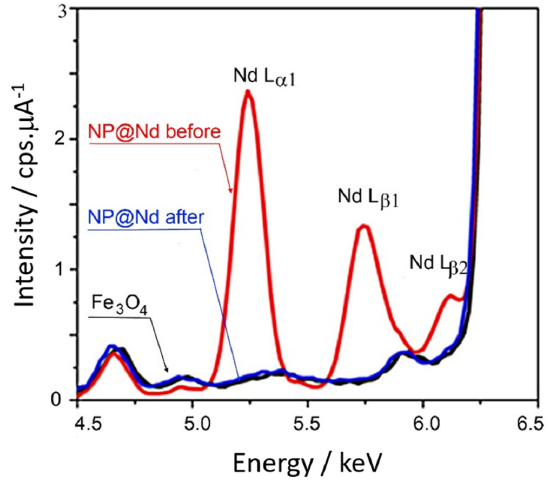
Figure 9. X-ray fluorescence analysis of the magnetic nanoparticles containing lanthanide ions, and after the treatment in acidic solutions at pH 2, showing the complete release of the metal elements (adapted with permission from [29]).